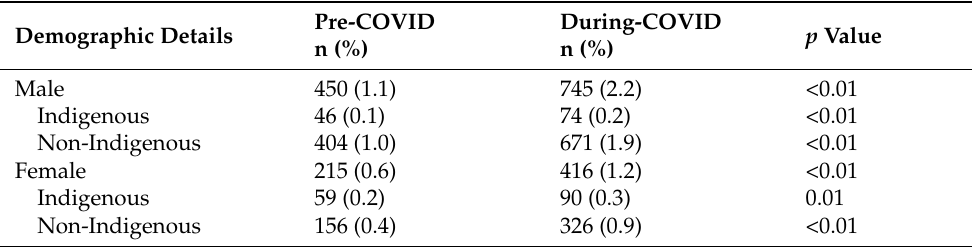
Table 1. Patients with SUD admitted through ED before and during COVID-19 stratified by gender and Indigenous status (denominator is the total number of admissions).